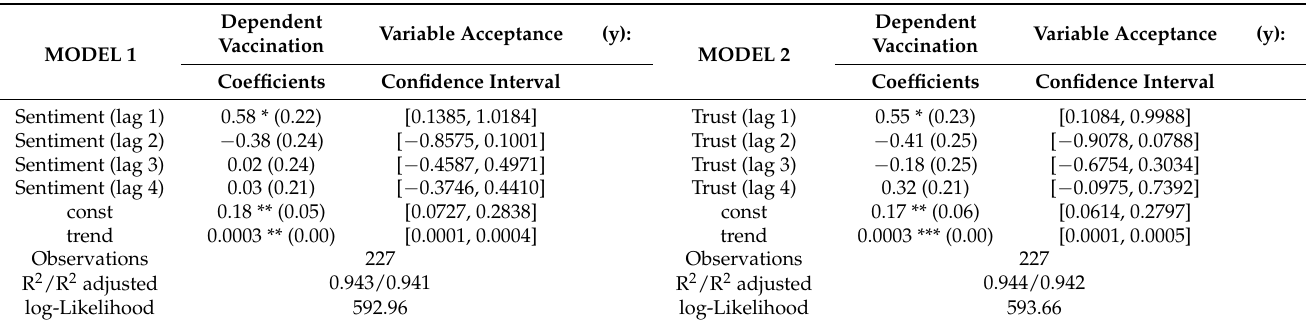
Table 3. VAR models of net sentiment and trust emotion of COVID-19 vaccination topic cluster predicting vaccination